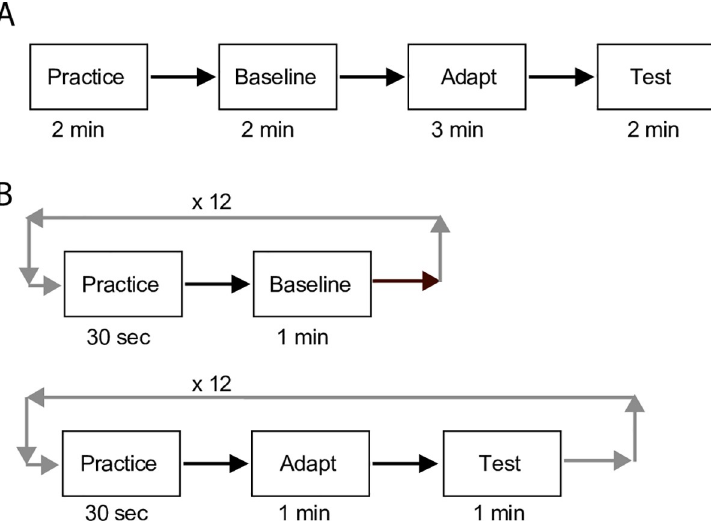
Fig 3. Design of experiments 1 and 2. Panel A shows the sequence and duration of blocks in the main sessions of Experiment 1. A 2 min block of practice was followed by a 2 min block of trials prior to adaptation (Baseline). Then 3 minutes of viewing the adapter stimulus was followed by an additional 2 min of trials (Test). Panel B shows the sequence of blocks for Experiment 2. Prior to adaptation, 30 sec practice blocks alternated with 1 min Baseline blocks. Twelve blocks of each were performed with the secondary task switching after each Baseline block. Next, during adaptation, 30 sec practice blocks alternated with 1 min blocks of trials (Test) with 1 min of the adapting grating presented in between. Again, twelve blocks of each were performed, with the secondary task switching after each Test block. (see text for details).